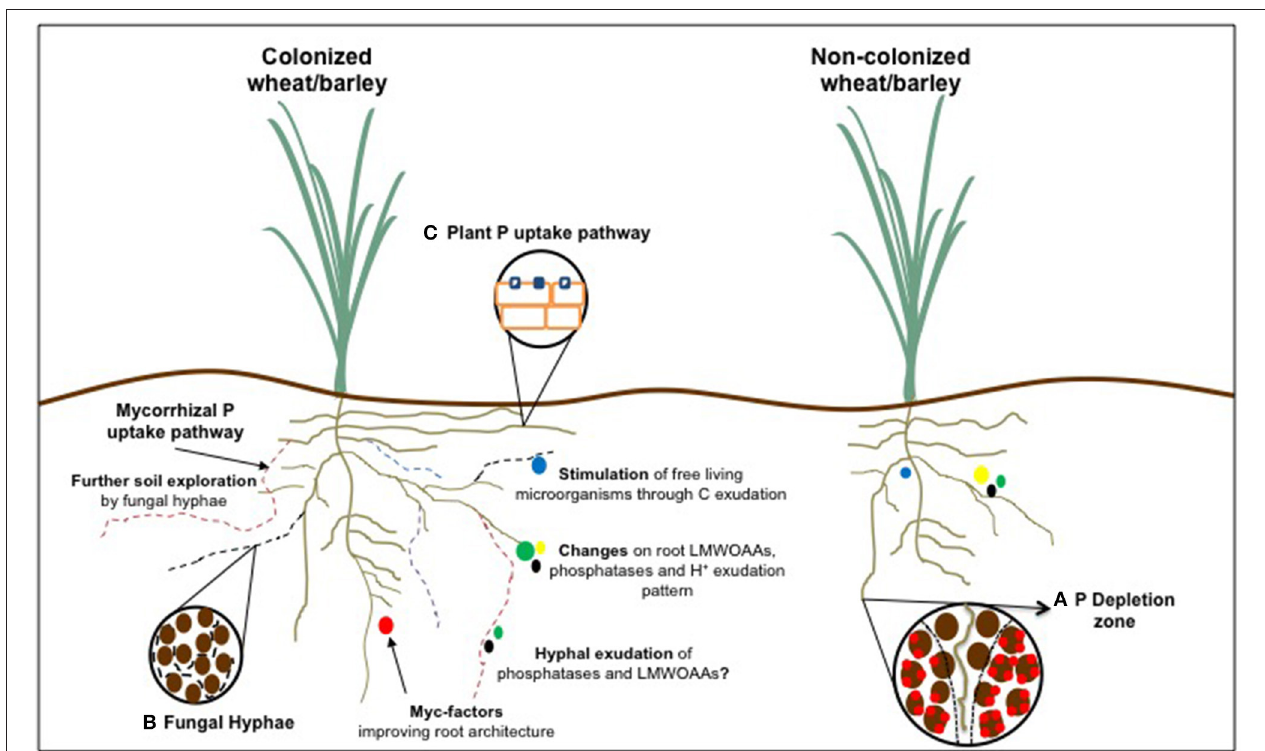
FIGURE 1 | Phosphorus acquisition efficiency related traits of wheat and barley roots affected by arbuscular mycorrhizal symbiosis in comparison to a non-colonized counterpart. (A) Representation of P depletion zone around the rhizosphere; (B) Access to smaller soil pores by AM fungal hyphae; and (C) Modulation of plant P transporters following